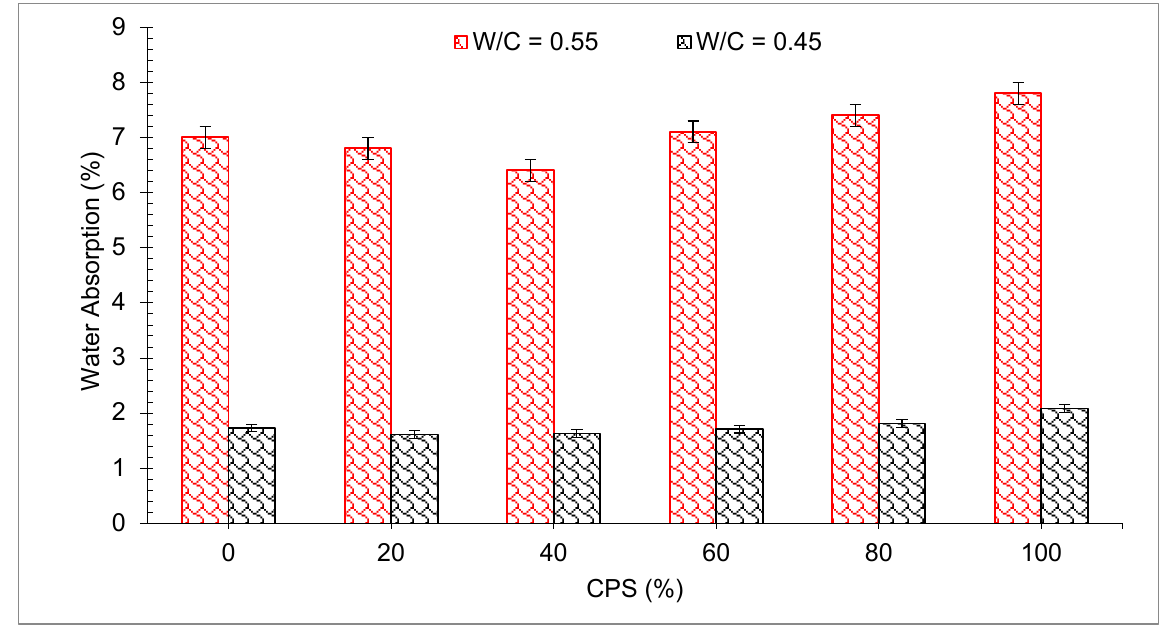
Figure 15. Water absorption of concrete: data source [47].